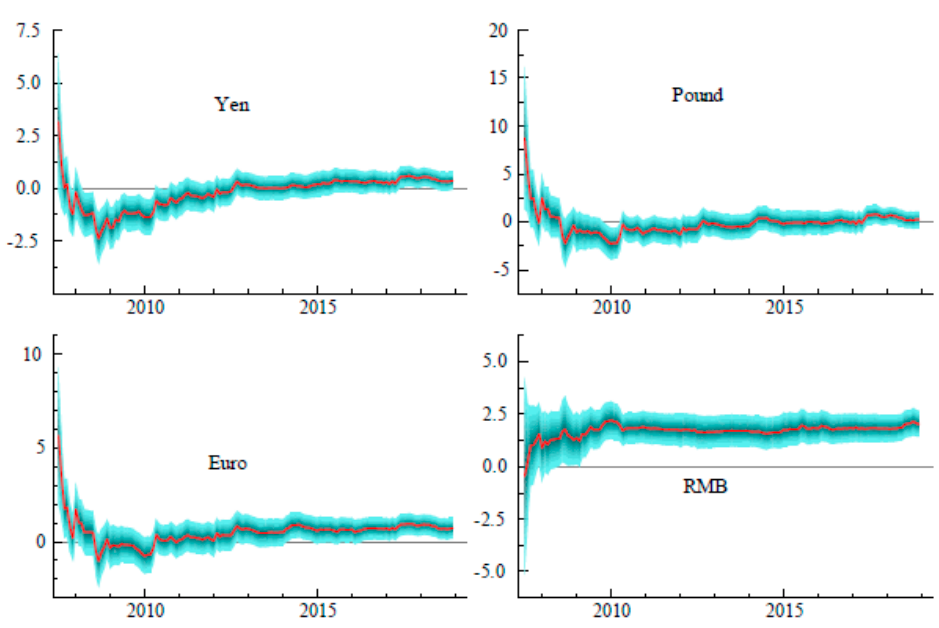
Figure 8. Recursive Estimate of Coefficient for Bilateral Exchange Rates. Bands represent twice the standard deviation of the estimate.